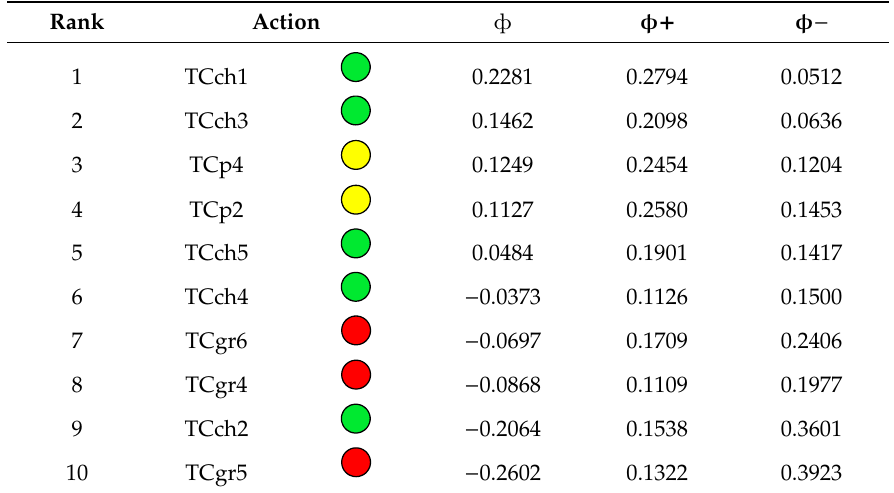
Table 7. Preference Ranking Organization Method for Enrichment Evaluations (PROMETHEE) ranking of the possible reservoir sites from the most equitable and reasonable to the least one (the colors are the same used in Figure 10 to represent the three clusters).